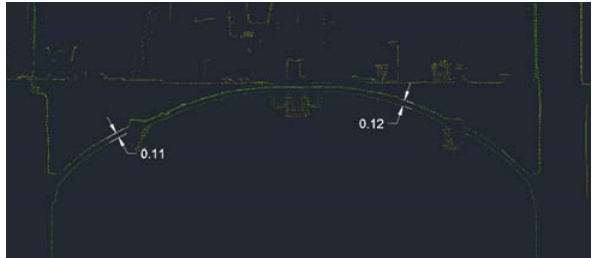
Figure 15: Point cloud section during the restoration works. The measure of the vault section can be obtained.